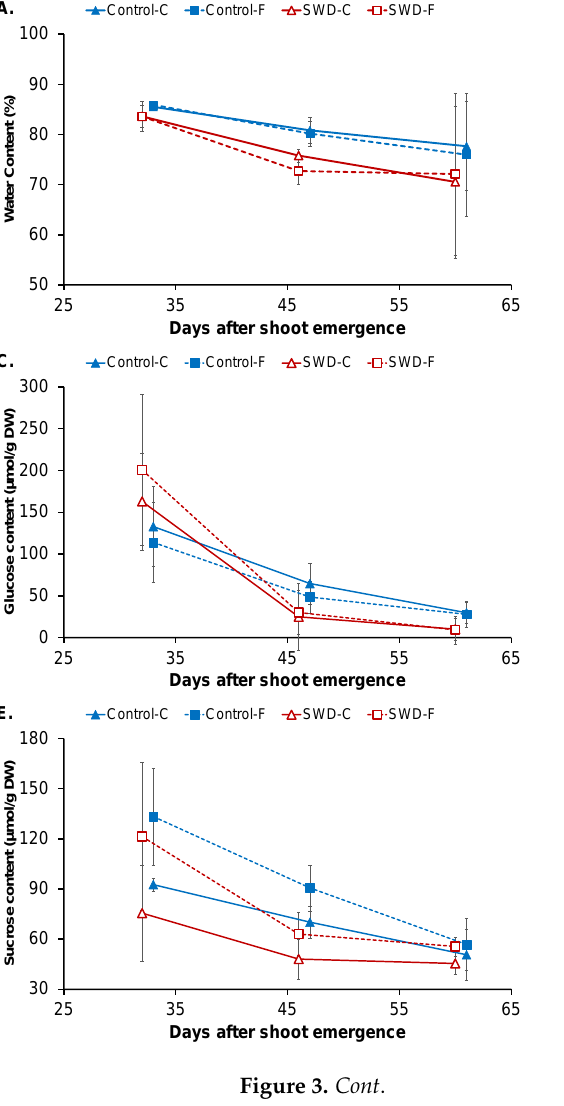
Figure 2. Evolution of ( A ) pH and ( B ) redox potential corrected for pH = 7 (Eh (pH7)) in potato tuber tissues (C: Cortex; F: Flesh) during tuber filling expressed in days after shoot emergence for both control and severe water-deficit (SWD) conditions. Values correspond to the average of four observations ( n = 4) and standard deviation are indicated by the segment bars. The statistical significance of differences in value for tissues, growth periods and water regimes is reported in Tables 1, 2 & 3, respectively.